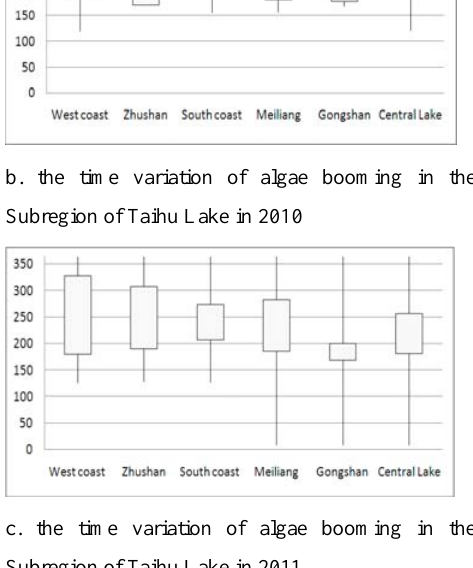
Figure 4 the monthly algae bloom duration of each Note: In the diagram, the top and low of each rectangle stand for the average of EBD and IBD in the subregion. The top and low of each vertical line indicate the date of the first EBD and the last IBD in this